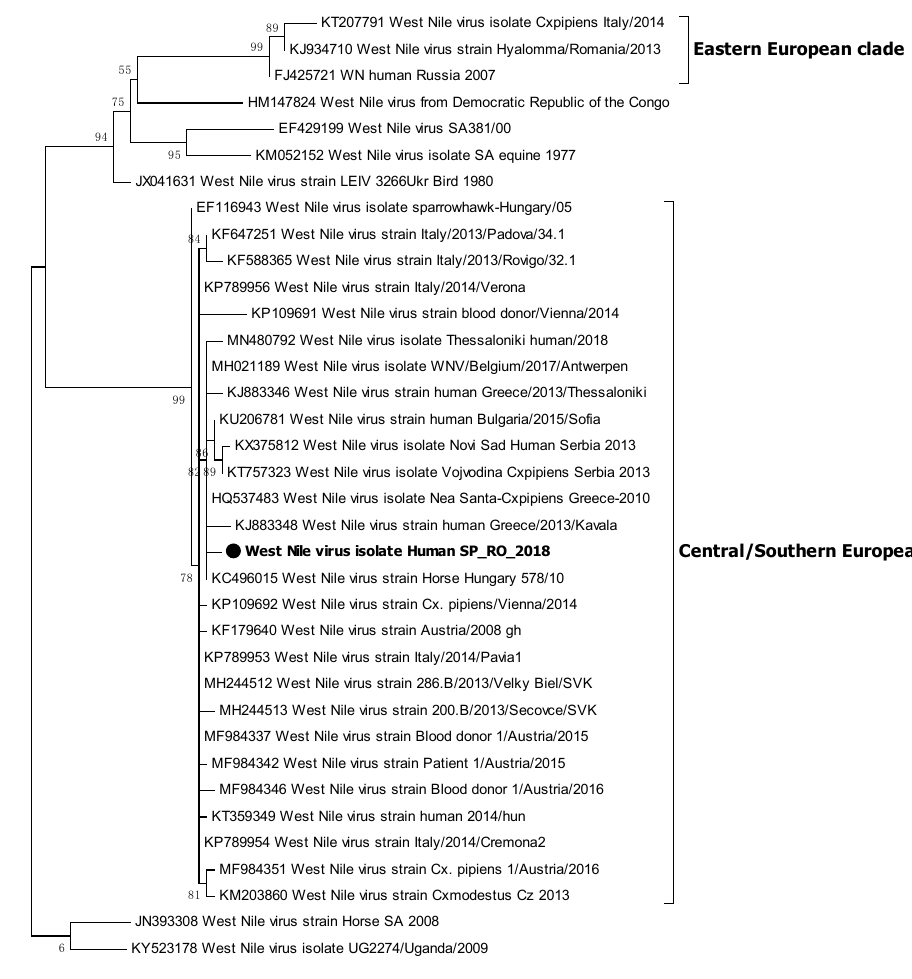
Figure 1. The tree was created with the maximum likelihood method in PhyML, based on 1032 nt of WNV-2 sequences available from NCBI GenBank (accession numbers provided). Black circle: sequence obtained in this study from human samples. GenBank accession number: MN966983. The TN93 + G model was used and the α LRT SH-like value was analyzed.